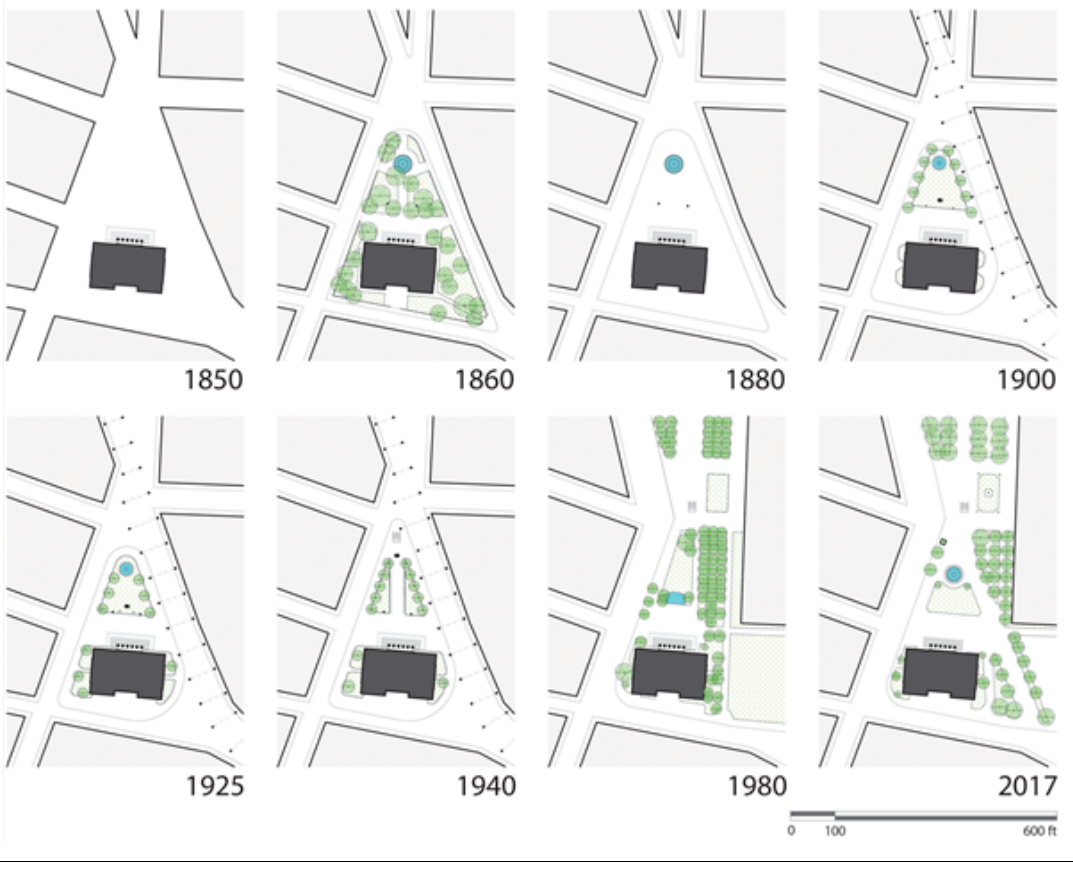
Figure 8. Diagram of the changing conditions of City Hall Square (Source: